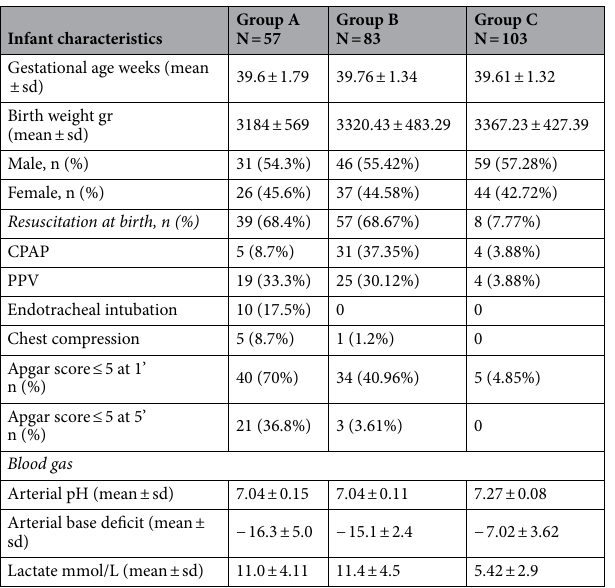
Table 1. General characteristics of the studied population. GBS, Streptococcus Agalactiae; PROM, premature rupture of membranes; CS, cesarean section; CPAP, continuous positive airway pressure; PPV, positive pressure